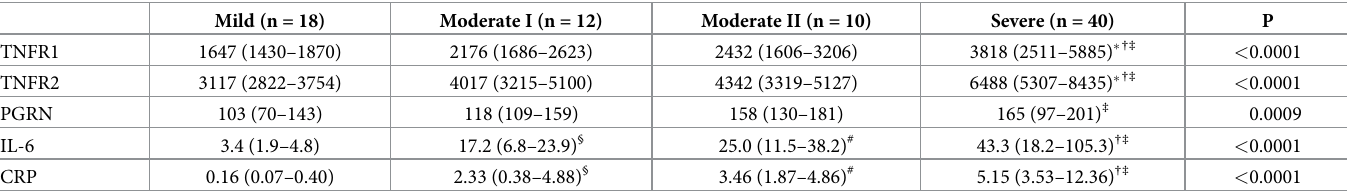
Table 2. Circulating levels of inflammatory markers in relation to disease